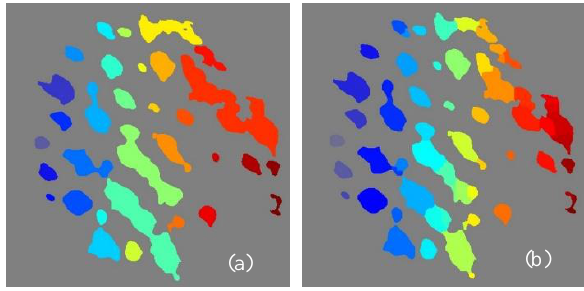
Figure 8. Visualisation of the segmentation before (a) and after (b) the refinement through a neighboorhood analysis